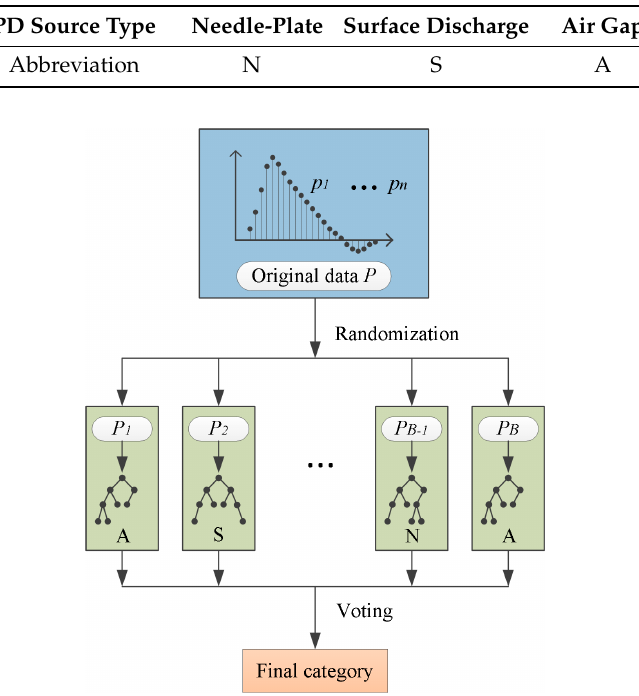
Figure 11. Flowchart of PD source type classification with RF.